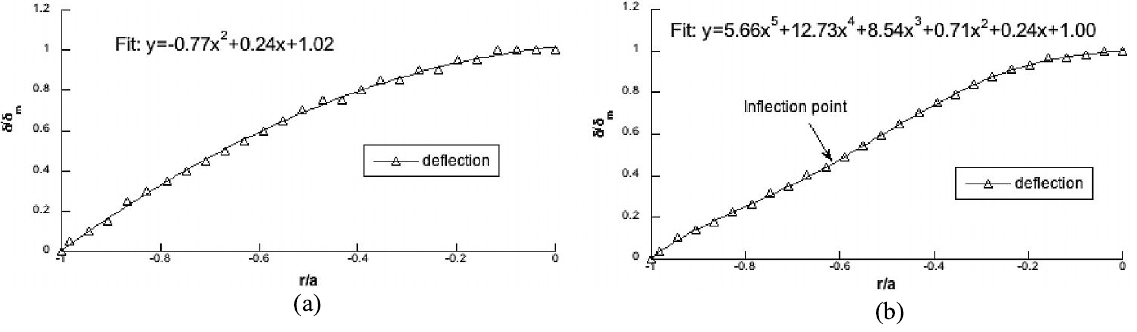
Fig. 5. Deformation profiles for plates that did not rupture: a) parabolic shape, b) inflection